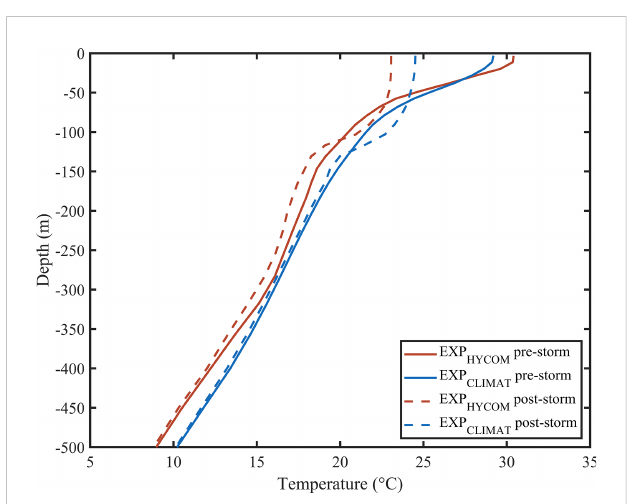
FIGURE 7 Vertical temperature pro fi les on July 8 (solid lines) and when the maximum sea surface cooling occurred after the passage of Soulik (dashed line) in EXP HYCOM (red) and EXP CLIMAT (blue) at